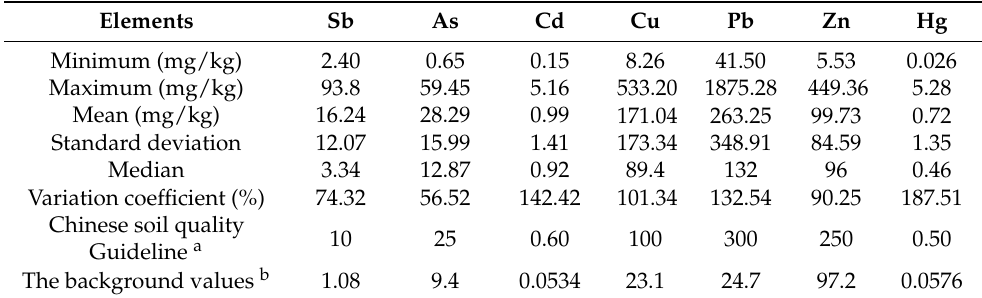
Table 3. Statistical analysis of PTE concentrations in soil samples near the tailing